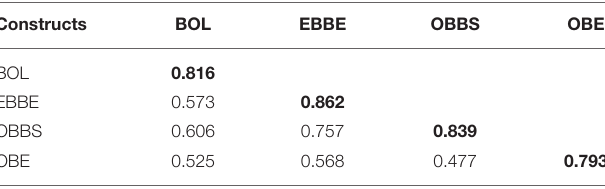
TABLE 4 | Discriminant validity